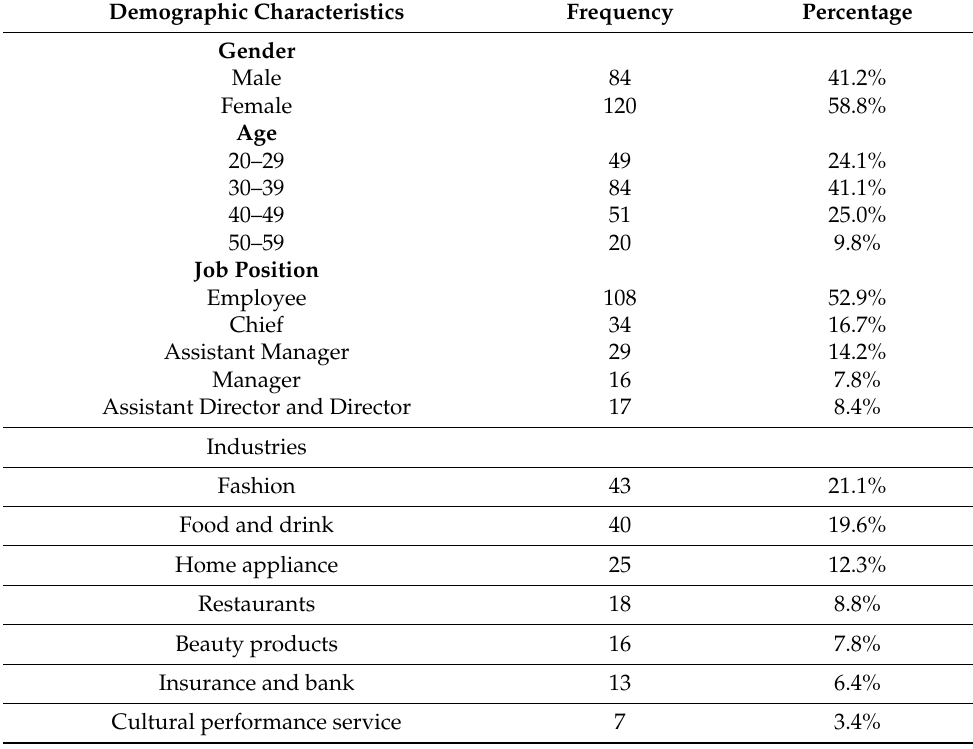
Table 1. Demographic